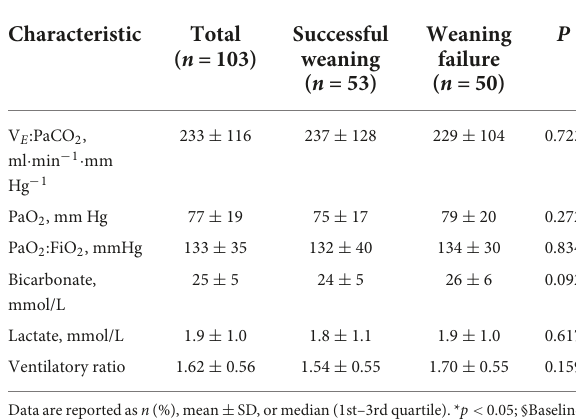
TABLE 1 Characteristics of the patients at baseline.